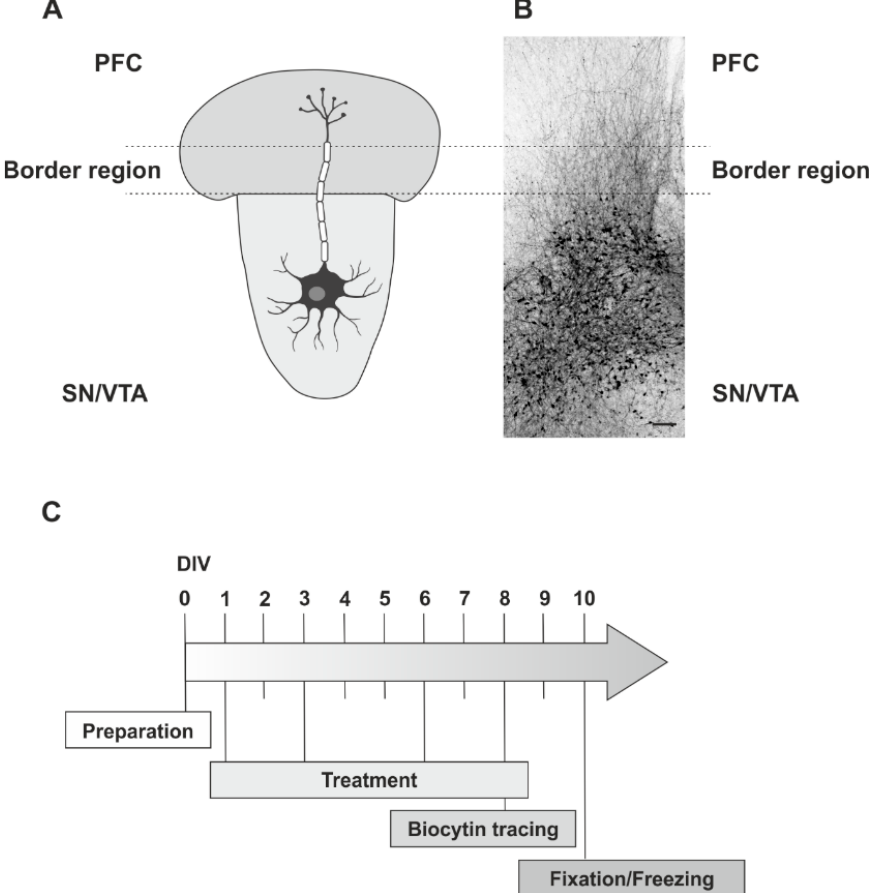
Figure 1. Experimental design. ( A ) Schematic Illustration of the used organotypic ex vivo slice co-cultures of the dopaminergic system (SN/VTA and PFC) (Attribution: Free neuron vector from vecteezy: Available online: https://www.vecteezy.com/free-vector/nerve-cell (accessed on 23 July 2021). Nerve Cell Vectors by Vecteezy. ( B ) Overview of the fibre outgrowth visualized by biocytin tracing in an ex vivo co-culture system (rat, fixed at DIV 10). The dotted lines characterize the border region, used for quantification of fibre density. ( C ) Timeline with the treatment procedures. Scale bar: B = 200 µ